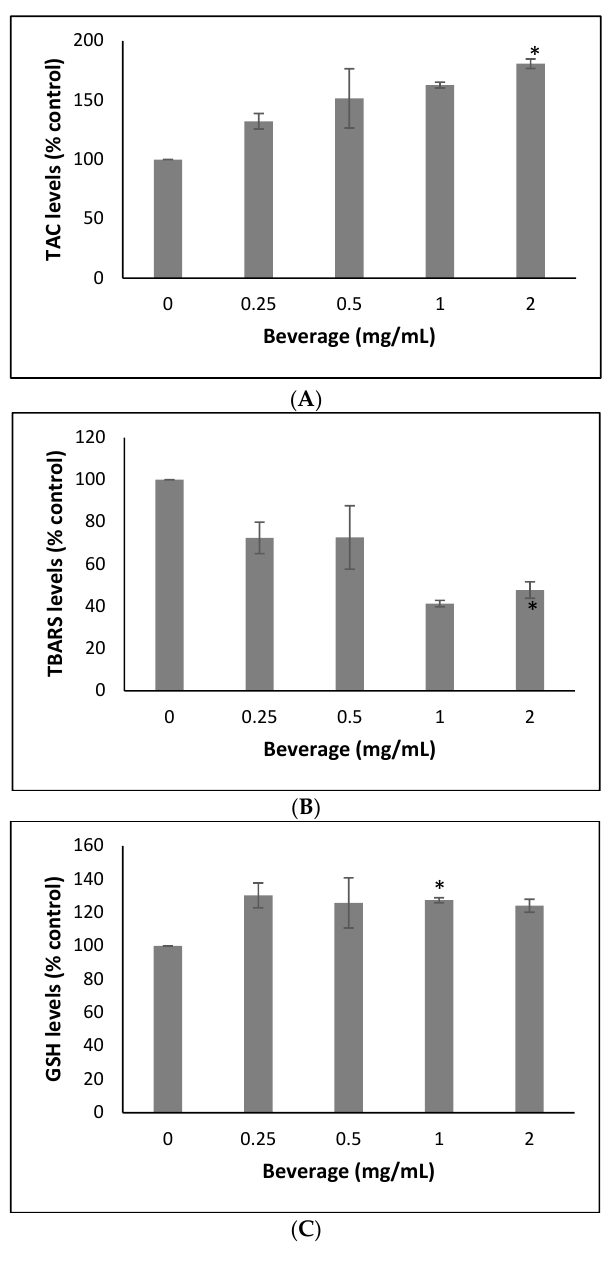
Figure 3. Effects of the sports beverage on ( A ) TAC, ( B ) TBARS levels and ( C ) GSH levels. All values are presented as the mean ± SD of three experiments. * means that levels were statistically significant compared to control ( p < 0.05).